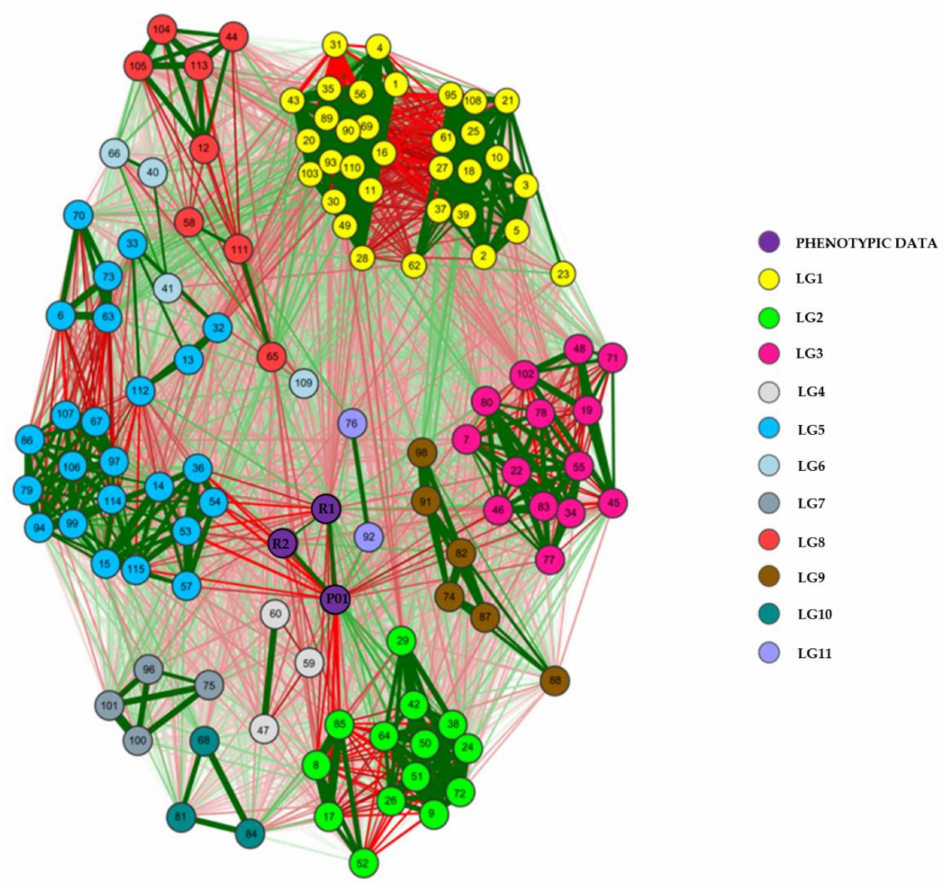
Figure 3. Correlation network among the molecular markers of each linkage groups (LG) of the genetic map and phenotype obtaining by coffee inoculation with race I, race II, and the pathotype 001 of Hemileia vastatrix . LG1–LG11 = Linkage Groups of the genetic map, 1–115 = molecular markers. Phenotypic data: R1 = race I, R2 = race II, and P01 = pathotype 001. The width of the line is proportional to the intensity of the